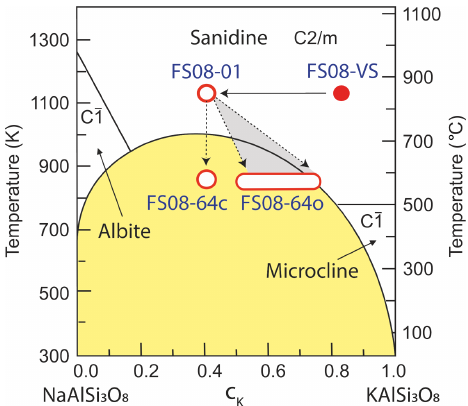
Figure 1. Schematic isobaric phase diagram for alkali feldspar showing the stability fields and respective symmetries of albite, sanidine, and microcline; the miscibility gap (the shaded yellow re- gion under the solvus curve) represents the two-phase region; the filled red circle shows the original composition of the Volkesfeld sanidine (sample FS08-VS), which was shifted to intermediate com- position by cation exchange at 850 ◦ C (sample FS08-01); subse- quent annealing at 550 ◦ C in vacuum produced sample FS08-64c, and annealing at 550 ◦ C in contact with the NaCl–KCl salt produced sample FS08-64o with a somewhat variable composition due to in- complete cation exchange (see